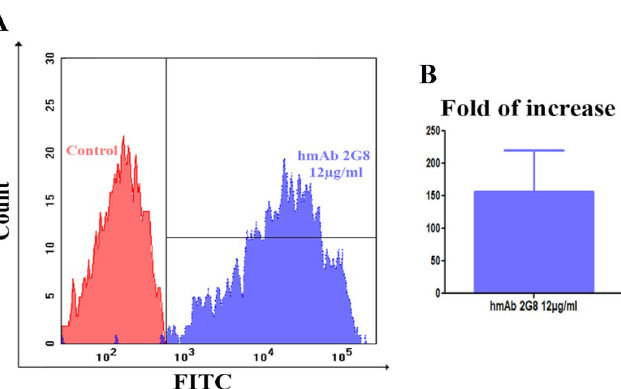
Figure 5. ( A ) Binding analysis by flow cytometry. Overlays of red histogram (from control sample) and blue histogram (from hmAb 2G8-labelled sample). ( B ) MFI fold of increase between the sample and the